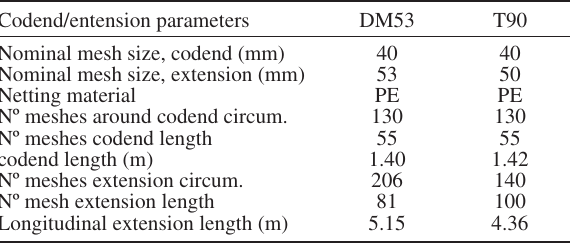
Table 1. – Nominal sizes of the standard (DM53) and the experi- mental net (T90). Codend/entension